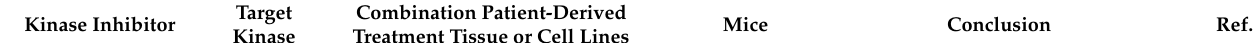
Table 4. Recent mouse xenograft studies evaluating kinase inhibitor treatments in in vivo setting. Target Combination Patient-Derived Kinase Inhibitor Mice Conclusion Ref. Kinase Treatment Tissue or Cell Lines Broad anti-tumor effect irrespective of HR tumor status. Combination Olaparib PDX − treatment reduced tumor metastasis and prolonged overall